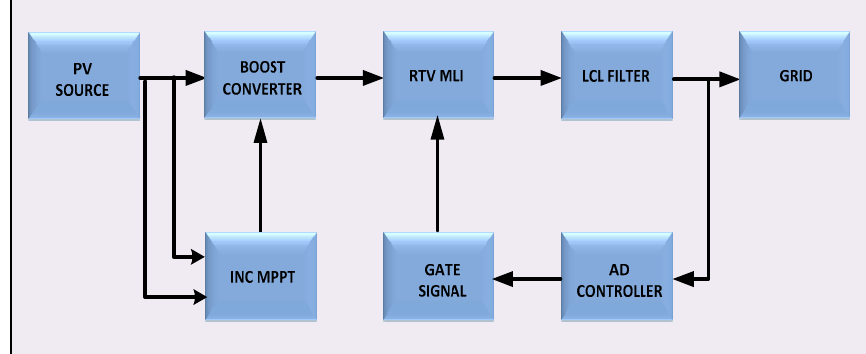
Figure 1. Grid interfaced RVT multi-level inverter fed with LCL filter.